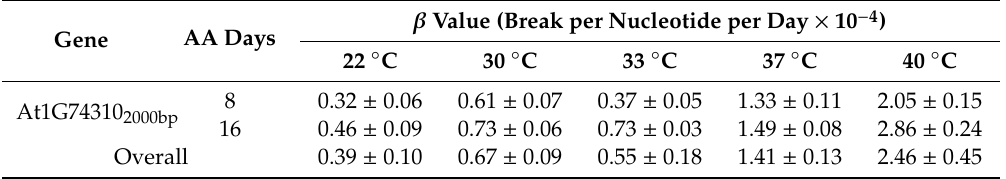
Figure 5. Estimated β values for one stored mRNA gene in Arabidopsis seeds aged at different temperatures and days. Seeds were treated at 22, 30, 33, 37, and 40 °C for 8 or 16 days, with seeds stored at 4 °C used as the unaged control. The β value was estimated as described in the Materials and Methods using the ∆ Ct value for the 2000bp fragment of Arabidopsis gene At1g74310; this gene was previously assayed by Zhao et al. [45]. Each β value was obtained from three technical replicates. Table 4. Estimated β values for one mRNA fragment in the Arabidopsis seeds under different AA temperatures and durations.